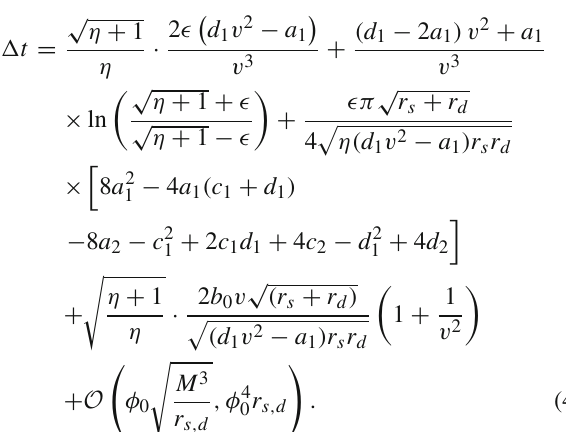
change of the angular coordinate (cid:2)ϕ( b b , t ) from the corre- sponding